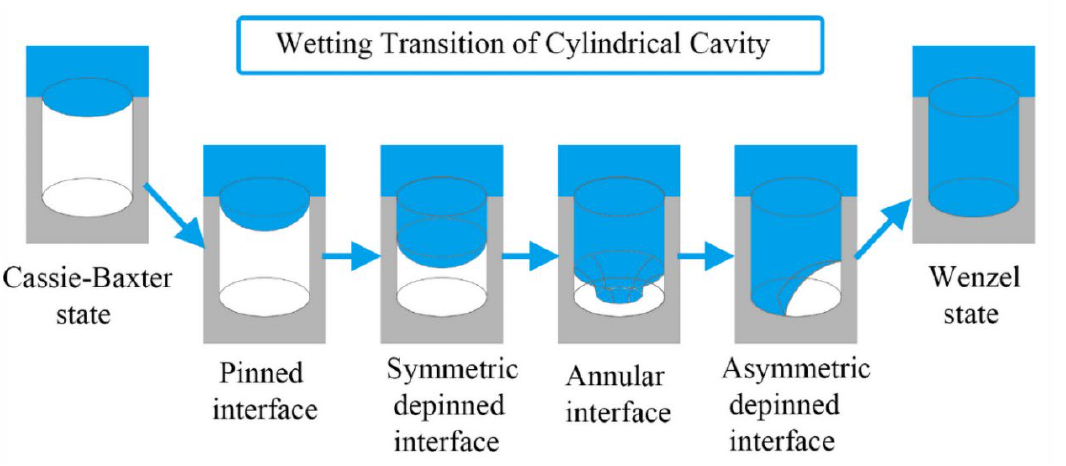
Figure 5. The asymmetric wetting transition mechanism of flat-top pillar microstructure of cylindrical cavity. Reprinted with permission from Ref. [89]. Copyright@2018, the Journal of Physical Chemistry.